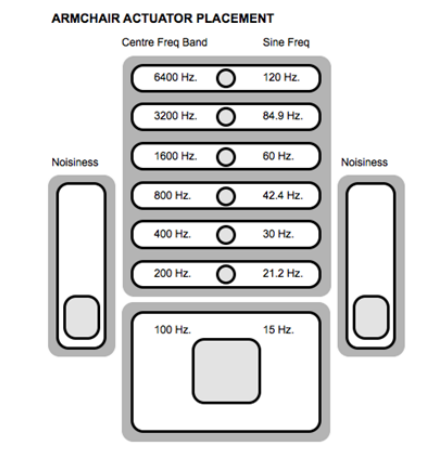
Figure 5. Spatialization of frequencies in a haptic chair, retrieved from in